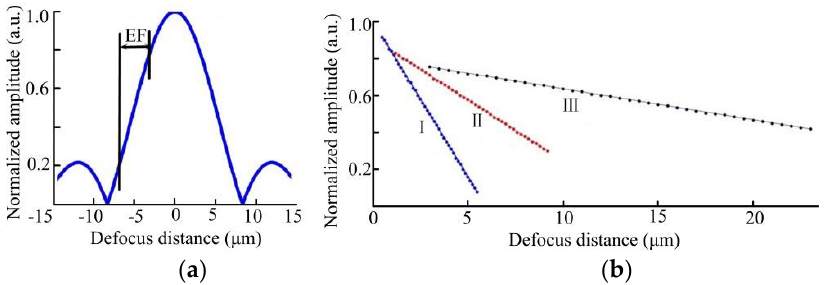
Figure 19. ( a ) The normalized defocusing curve, and ( b ) the calibrated linear range with different objective lenses. I, NA = 0.65, II, NA = 0.55, III, NA = 0.3. (Figure reproduced from Ref. [82]).